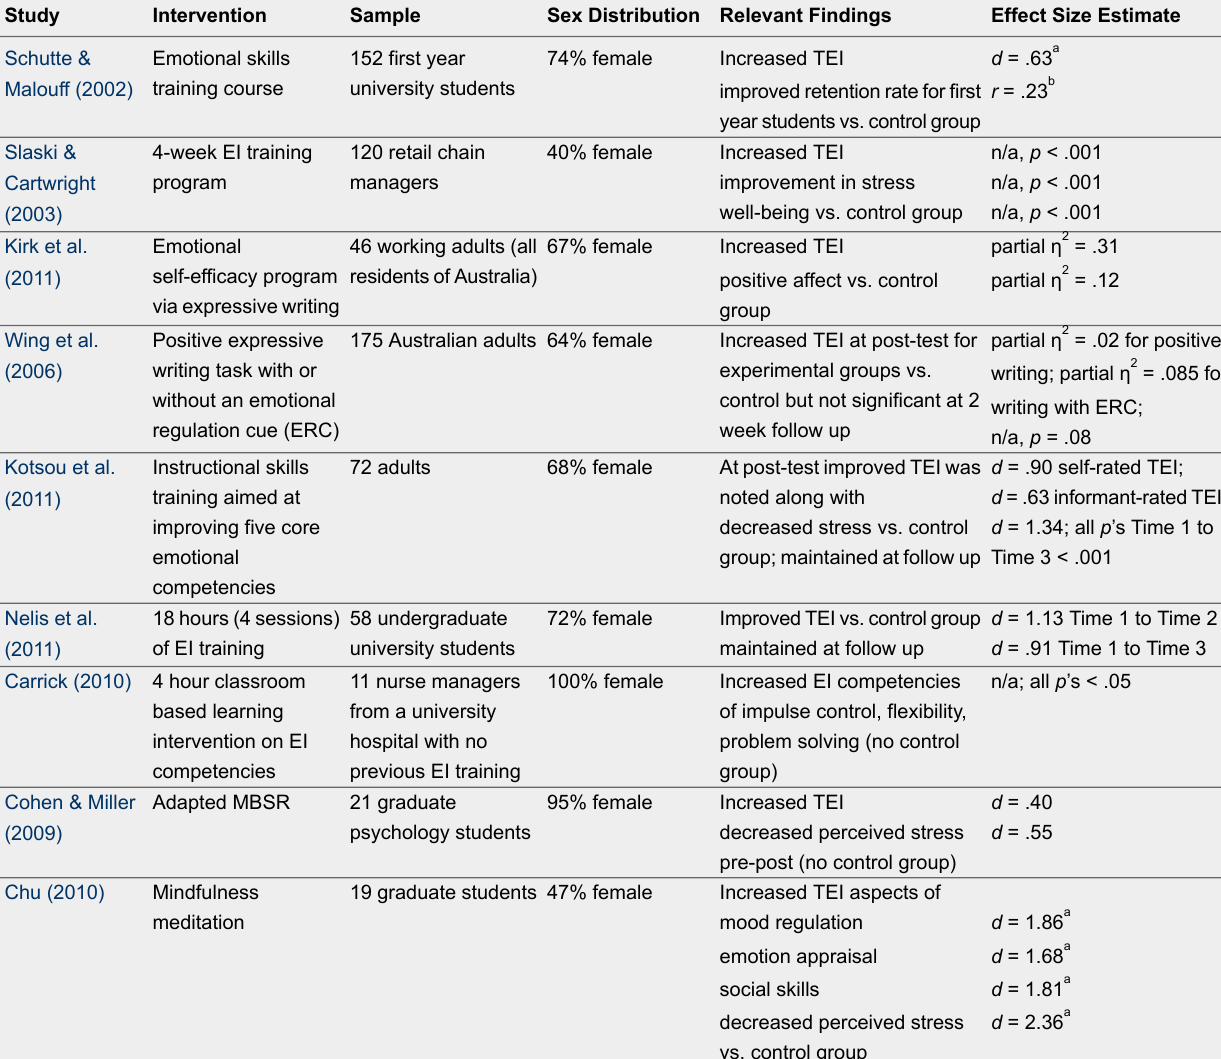
Summary of Psycho-Educational and Mindfulness-Based Interventions for